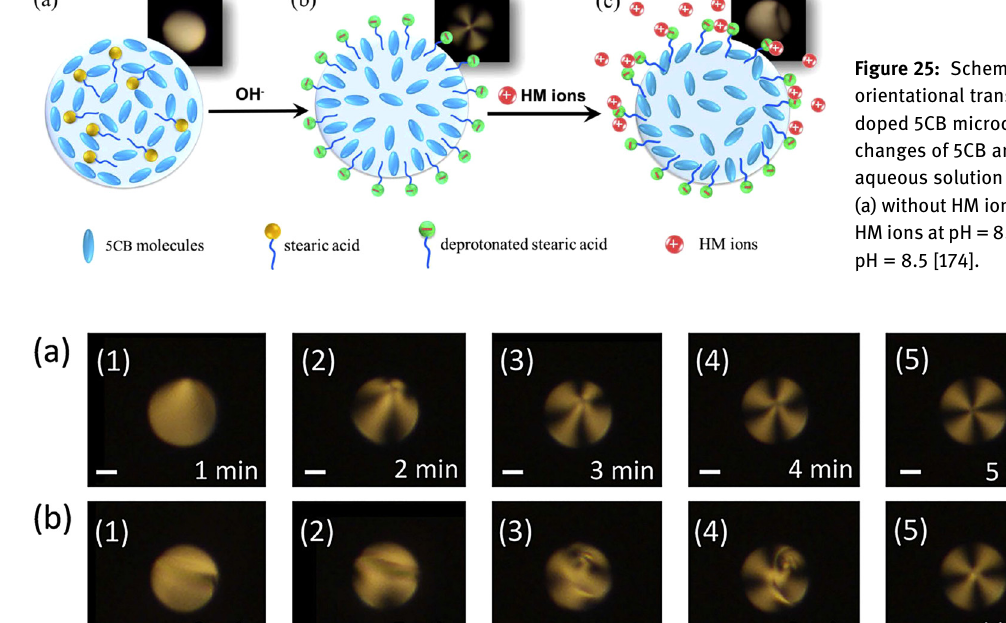
Figure 25: Schematic illustration of the orientational transition of stearic acid- doped 5CB microdroplets induced by changes of 5CB anchoring at the LC/ aqueous solution interface. (a) without HM ions at pH = 6.5; (b) without HM ions at pH = 8.5; and (c) with HM ions at pH = 8.5 [174].